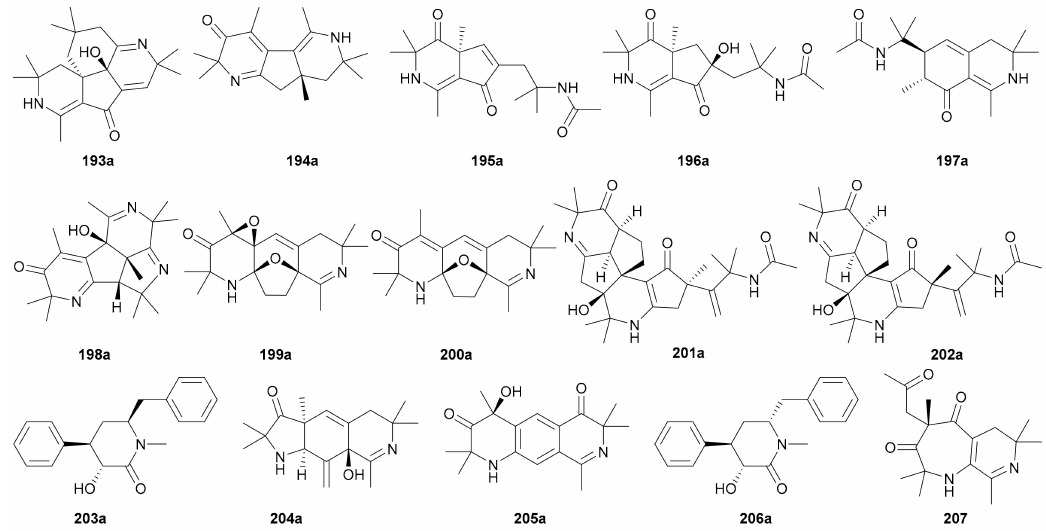
Figure 11. Structures of piperidine